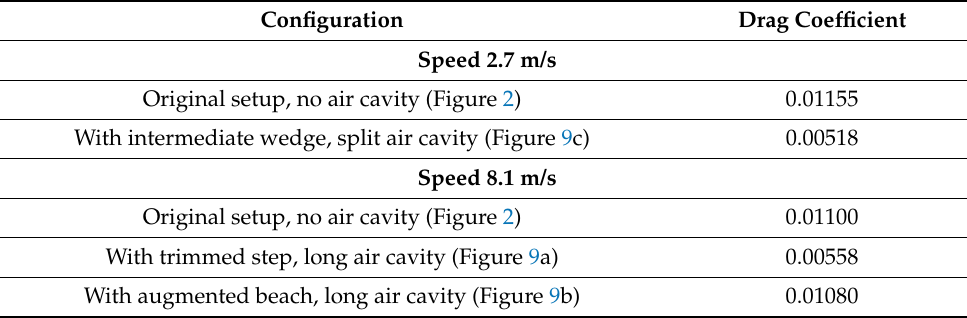
Figure 11. Stable air cavities under modified hulls: ( a ) with trimmed step at 𝑈 = 8.1 m/s and 𝑞 = 0.016, ( b ) with augmented beach at 𝑈 = 8.1 m/s and 𝑞 = 0.024, ( c ) with intermediate step at 𝑈 = 2.7 m/s and 𝑞 = 0.016. More detailed views of geometric modifications of the hull are given in Figure 10. Table 2. Drag coefficients of original and modified